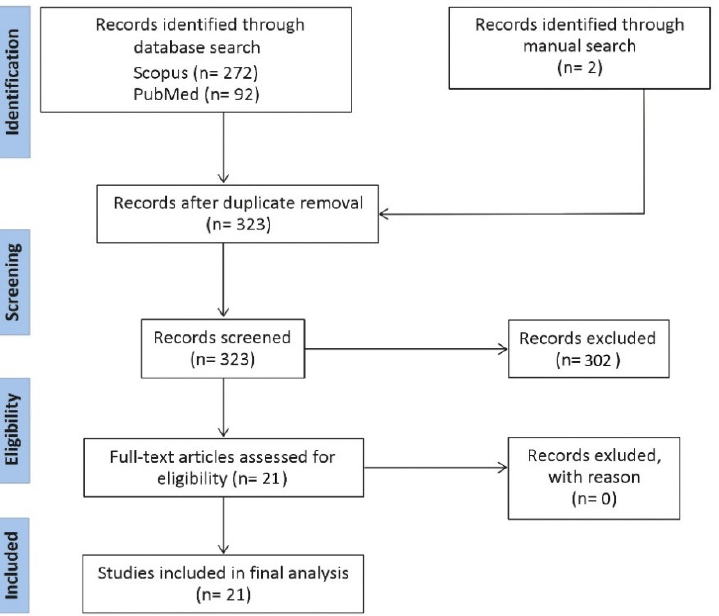
Figure 1. Flow diagram representing a summary of the methodology for this review.